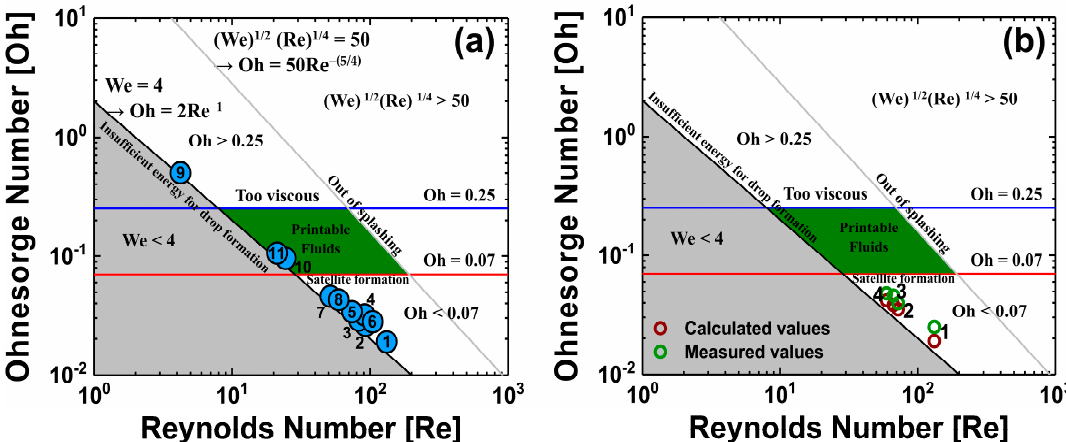
Figure 2. Ohnesorge map of ( a ) each organic solvents and ( b ) cosolvents inks of each mix ratio. Each dot with numbers on the Ohnesorge map represents the organic solvents from Tables 2 and 3, respectively. Table 2. List of solution properties of the organic solvents. In these experiments, hexane and oDCB were used in the cosolvent process because the solution properties between the two solvents are complementary. Solvent information was referenced from PubChem (U.S. National Library of